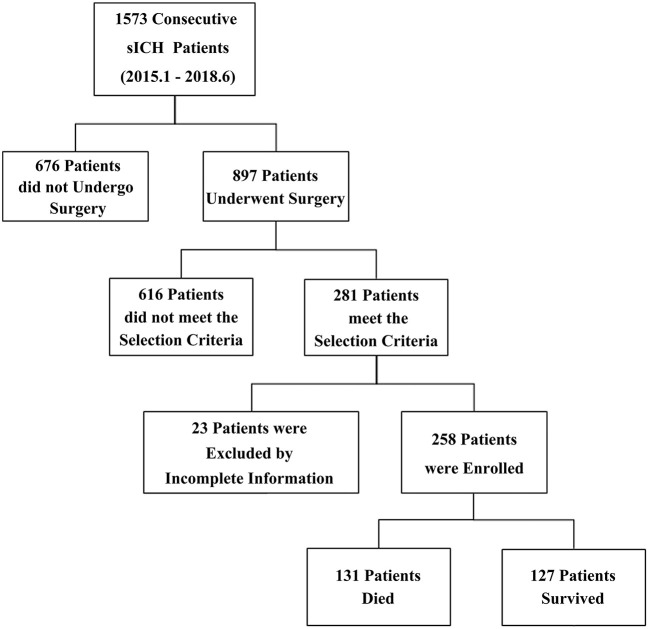
Enrollment in this study. A total of 1,573 consecutive sICH patients were reviewed. A total of 258 patients, including 131 non-survivors and 127 survivors, were enrolled according to the selection criteria.